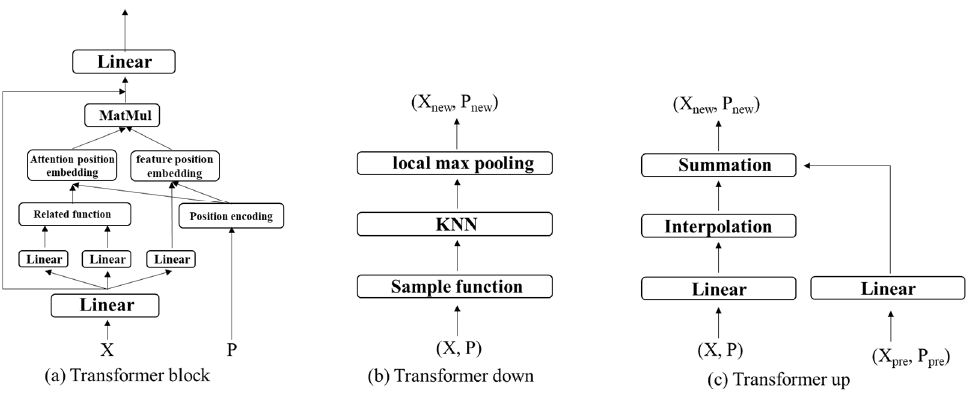
Figure 2. 3D mesh transformer block.